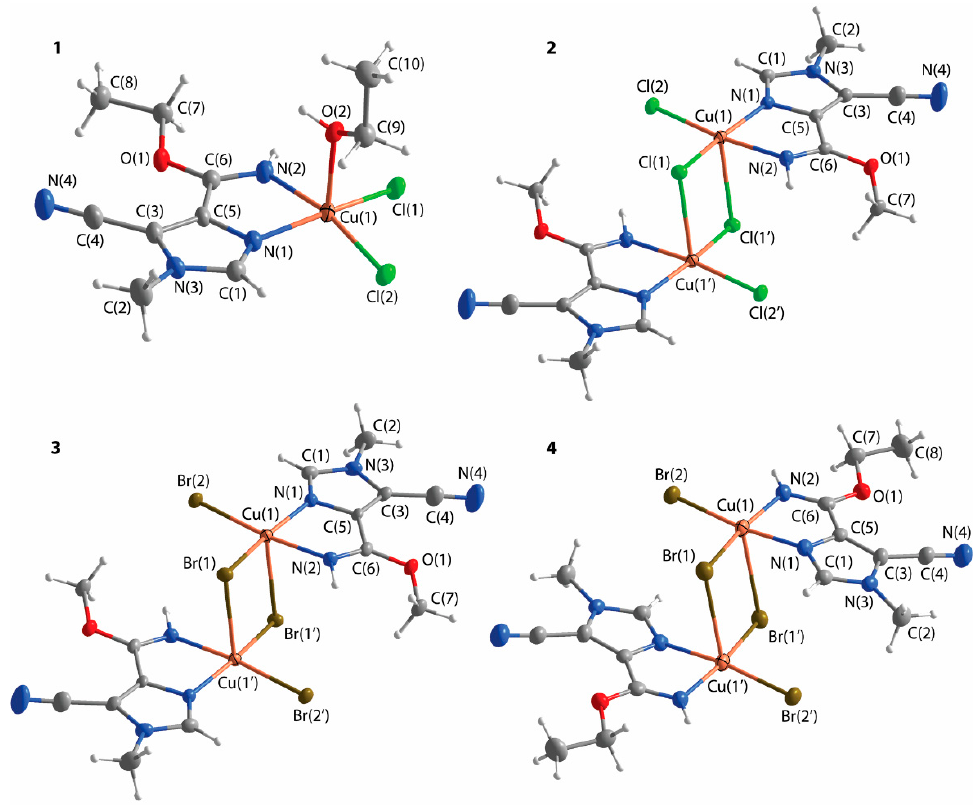
Figure 2. X-ray structures of [CuCl 2 (5-cyano-4-C(OEt)N-1-methylimidazole)(EtOH)] ( 1 ), [Cu 2 ( µ -Cl) 2 Cl 2 (5-cyano-4-C(OMe)N-1-methylimidazole) 2 ] ( 2 ), [Cu 2 ( µ -Br) 2 Br 2 (5-cyano-4-C(OMe)N-1- methylimidazole) 2 ] ( 3 ), and [Cu 2 ( µ -Br) 2 Br 2 (5-cyano-4-C(OEt)N-1-methylimidazole) 2 ] ( 4 ). Thermal ellipsoids are shown at 50% probability level.